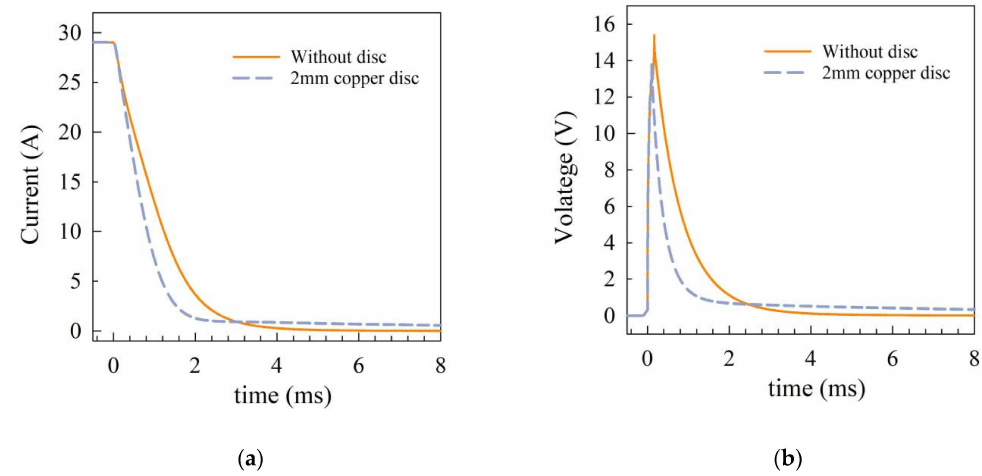
Figure 3. The ( a ) current and ( b ) voltage of the HTS coil during the discharging process with and without the copper